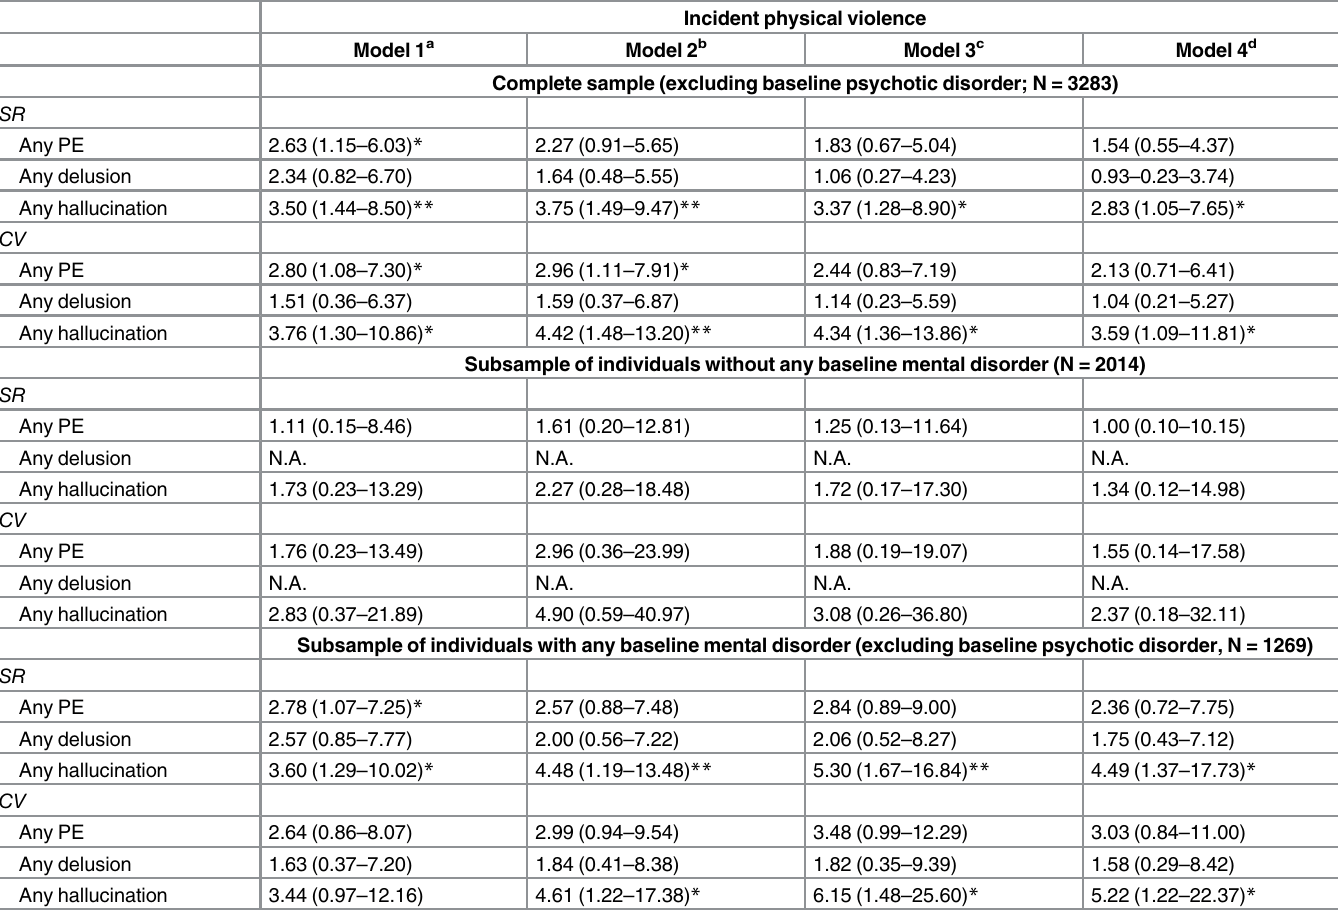
Table 2. Results (odds ratios and 95% CI) from logistic regression analyses on the association between self-reported (SR) and clinically validated (CV) psychotic experiences and six-year incidence of physical violence perpetration in a general population sample and two